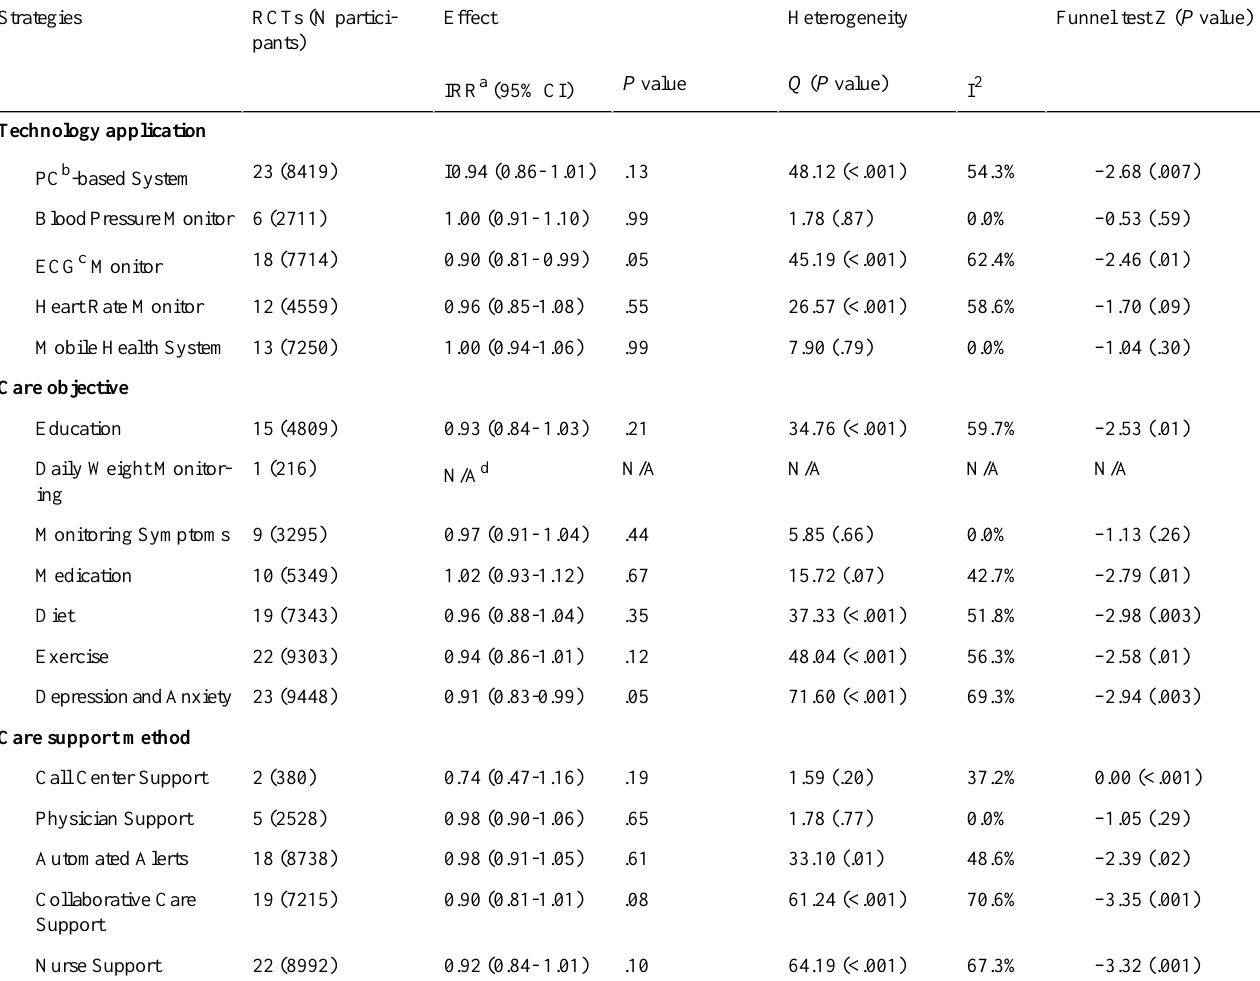
Table 5. Subgroup meta-analysis to examine the effect of telemonitoring strategies on all-cause hospitalization for randomized controlled trials (RCTs) that did not apply the strategy in the telemonitoring intervention (subgroup